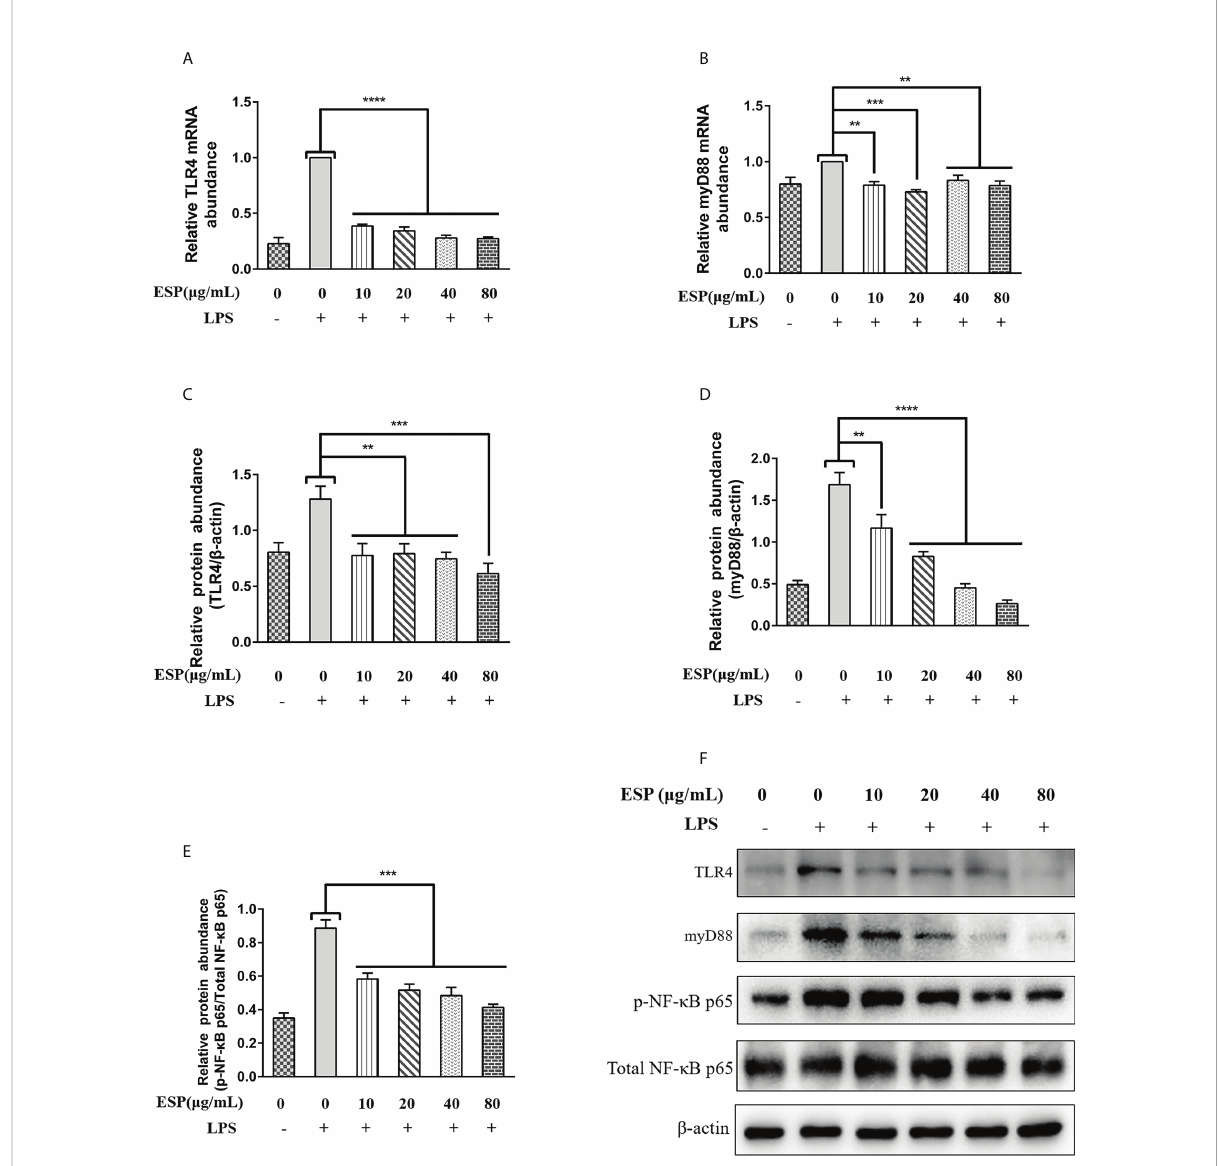
FIGURE 5 HcESPs reversed LPS-induced activation of the TLR4/NF- k B signaling pathway. Cells were stimulated with LPS (1 m g/mL) to establish an in fl ammation model, followed by incubation with different concentrations (0, 10, 20, 40, 80 m g/mL) of HcESPs at 37°C and 5% CO 2 for 24 h. A blank control group was set up (equal volumes of RPMI 1640 were used instead of LPS and HcESPs). (A, B) : Detection of relative transcript levels of TLR4 and myD88 in PBMCs by qPCR assays; (C – F) : Detection of relative protein expression levels of TLR4, myD88, p65, and p-p65 by Western blot; Data are presented as the mean±SEM from three independent experiments. Asterisks indicate signi fi cant differences at ** P <0.01, *** P <0.001, and **** P